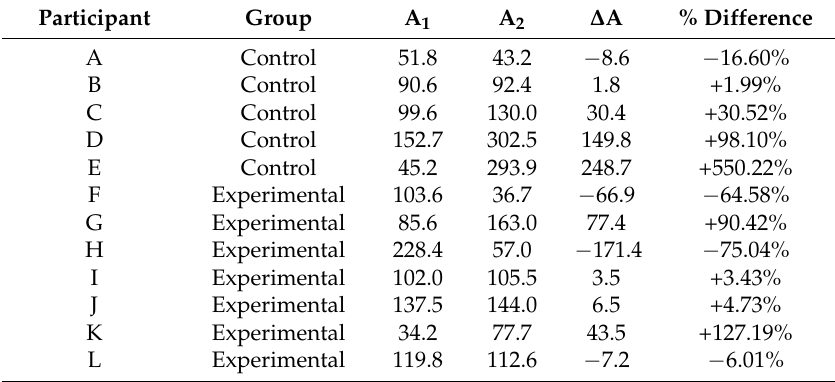
Table A2. Comparison of the change in participant posture, quantified as surface area.